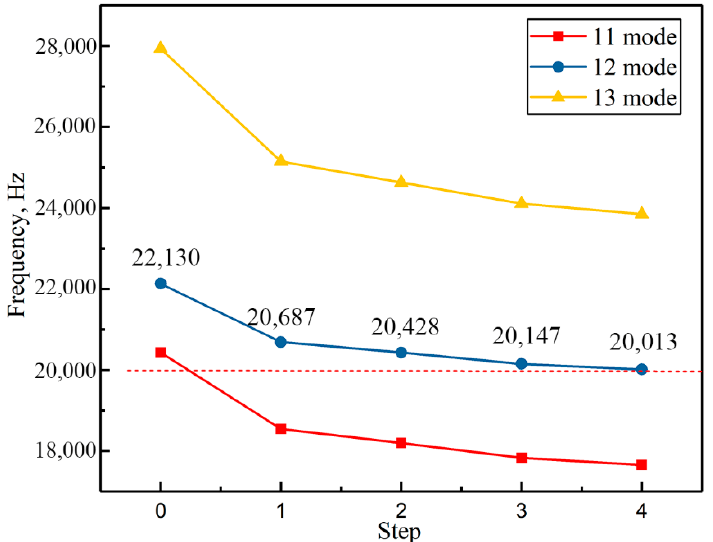
Figure 7. Frequency change during ultrasonic horn optimization, Step 0: before optimization, Step 1: the length of the large and small end simultaneously increased 5 mm, Step 2: the length of the large and small ends simultaneously increased 1 mm again, Step 3: the length of the large and small ends simultaneously increased 1 mm again, Step 4: the length of the large and small ends simultaneously increased 0.5 mm again.